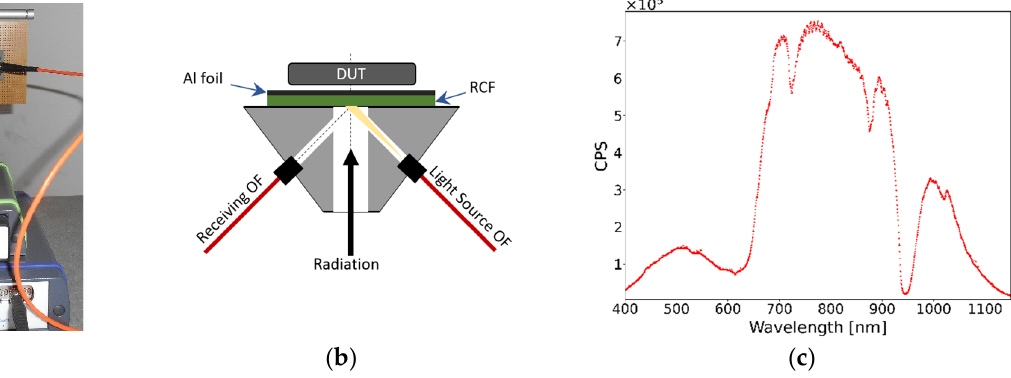
Figure 1. Picture ( a ) and scheme ( b ) of the dosimeter. The radiation interacts with the radiochromic film (RCF, green in the scheme ( b )), which darkens as a function of the dose. Two optical fibers (OFs) point at the RCF. One optical fiber transports the light from a light source, the other one acquires the light reflected by the RCF. An aluminum foil is placed on the side of the RCF not exposed to the light, in order to increase the collection of the reflected light. The device under test (DUT) is placed behind the RCF as the radiation first passes through the RCF and then it reaches the DUT. ( c ) Typical spectrum in counts-per-second (CPS) of an EBT3 Gafchromic film acquired with this setup.